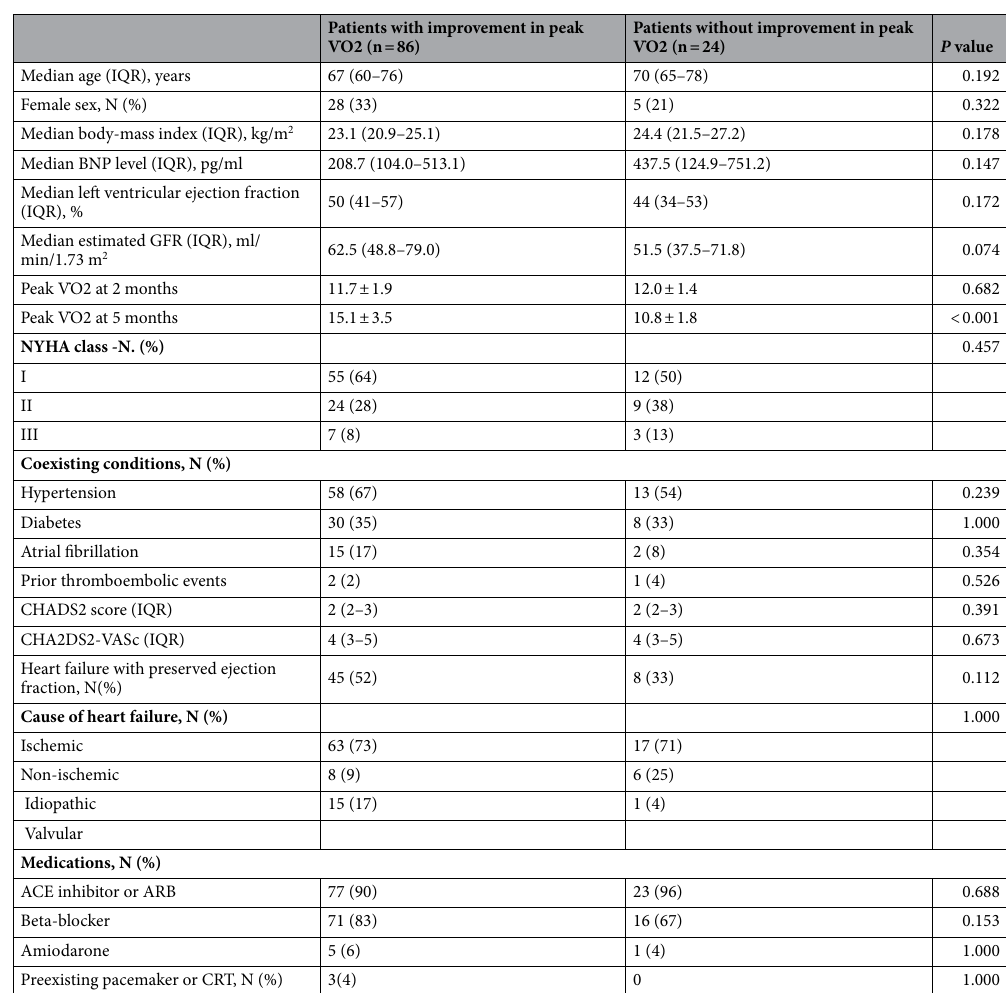
Table 2. Clinical characteristics of the higher-risk patients. IQR; interquartile range, GFR; glomerular filtration rate, NYHA; New York Heart Association, ACE; angiotensin-converting enzyme, ARB; angiotensin II receptor blocker, CRT; cardiac resynchronization therapy, BNP; brain natriuretic